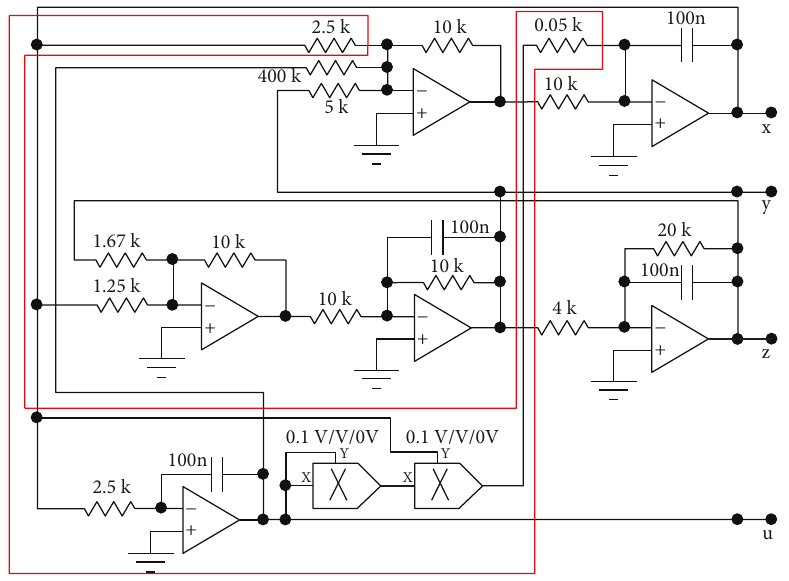
Figure 9: The novel memductor-based chaotic circuit